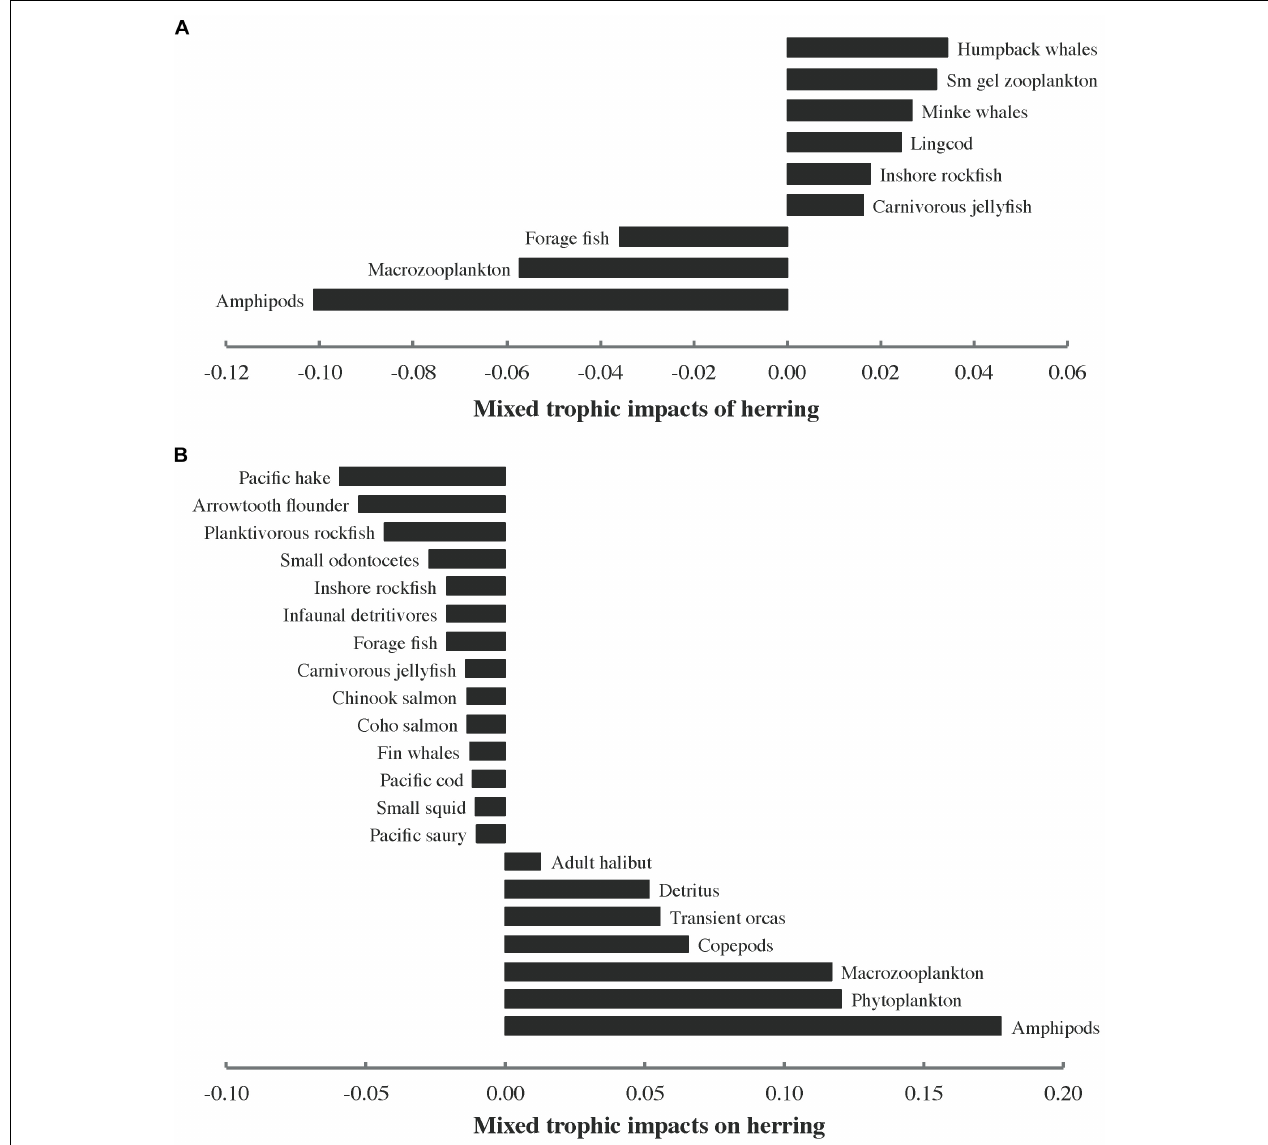
FIGURE 6 | Notable ( > 0.01) mixed trophic impacts ( MTI ) of (A) herring (all stocks and age/size classes combined) on other functional groups and (B) other functional groups on herring in the 1950 ecosystem model. Sm gel stands for small